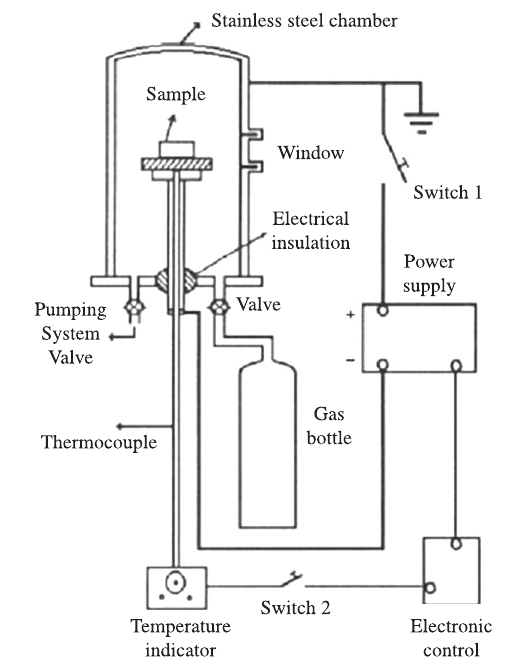
Figure 1. Schematic view of the plasma nitriding chamber with the samples